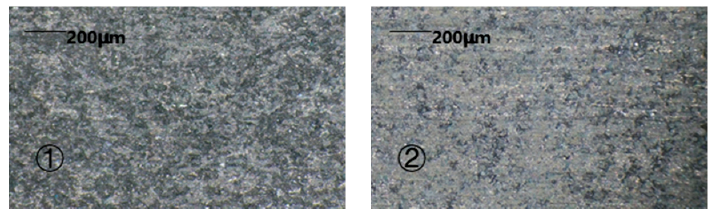
Figure 13. Resulting morphology with different solutions: ① NaCl, 4 mm/min; ② NaNO 3 , 4 mm/min.